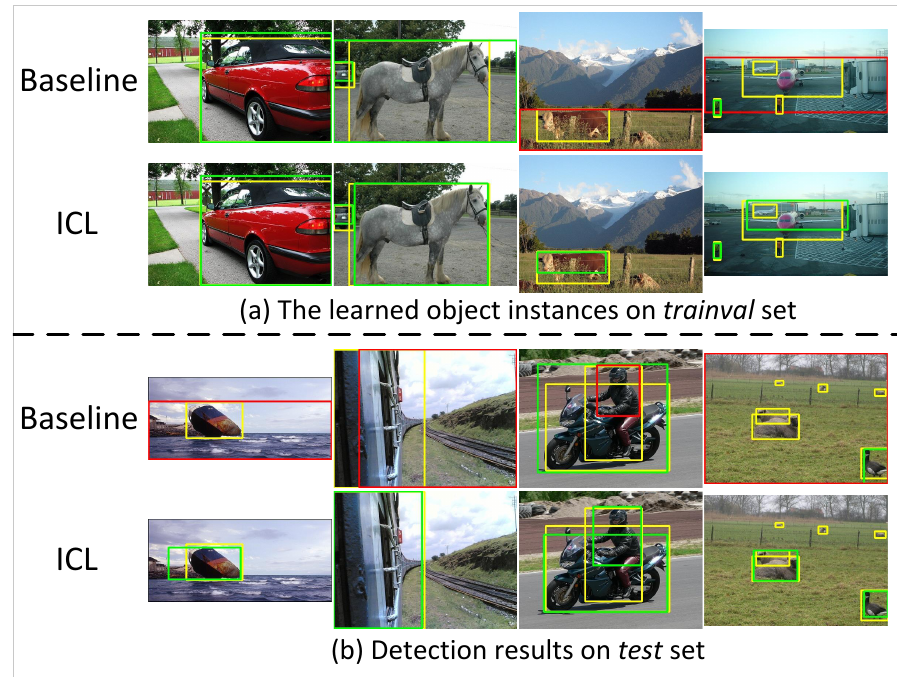
Figure 7. Qualitative results on PASCAL VOC2007 dataset. Yellow boxes mean ground truths. Green and red boxes represent correct and failed cases,